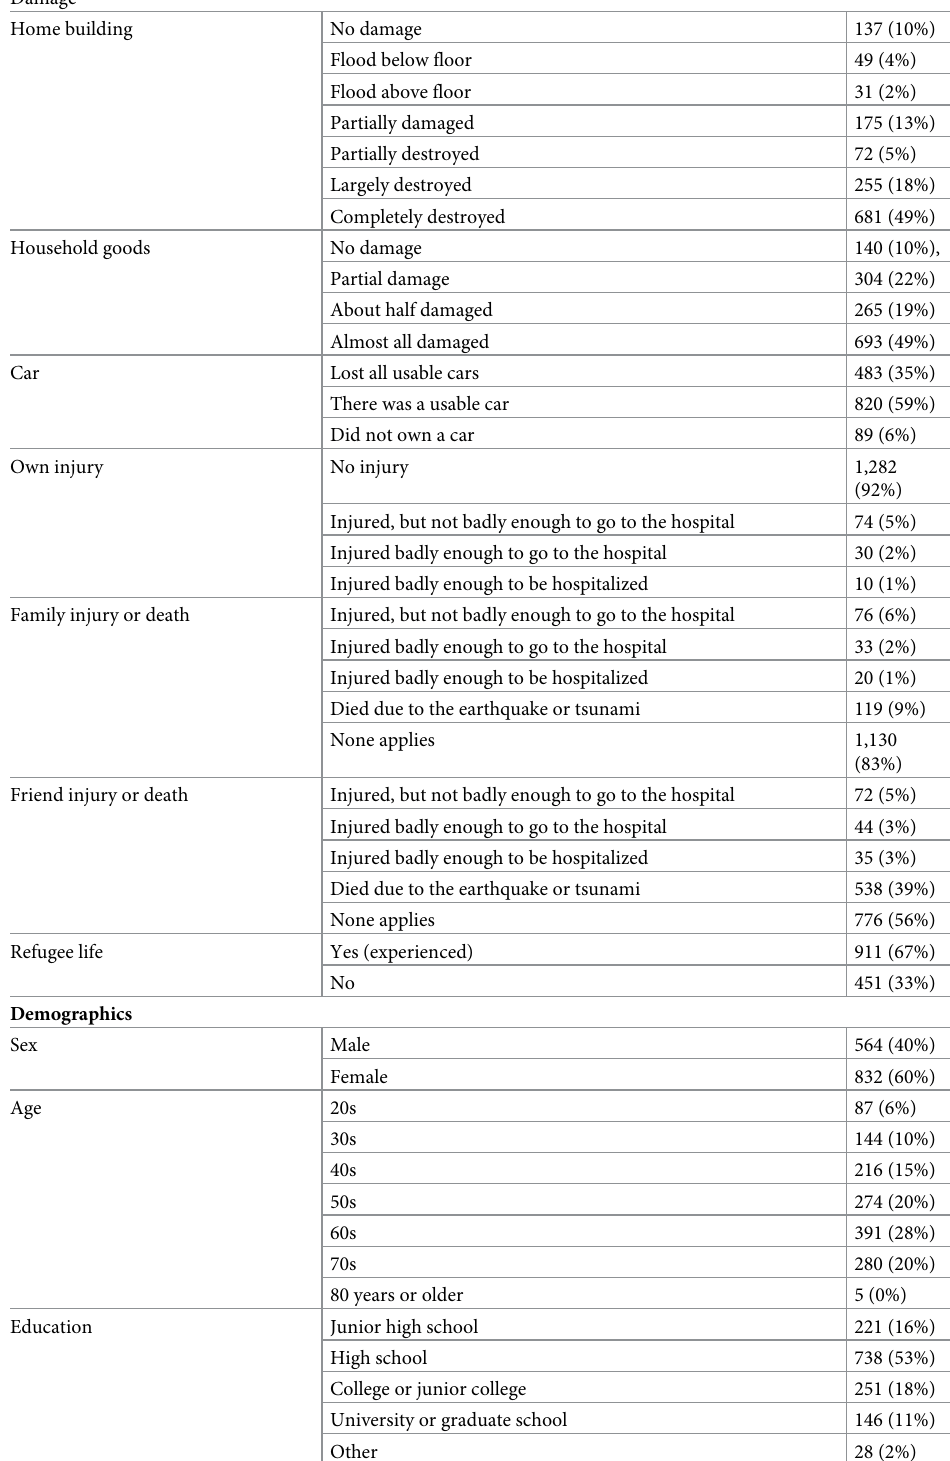
Table 1. Damage and demographic profiles of the